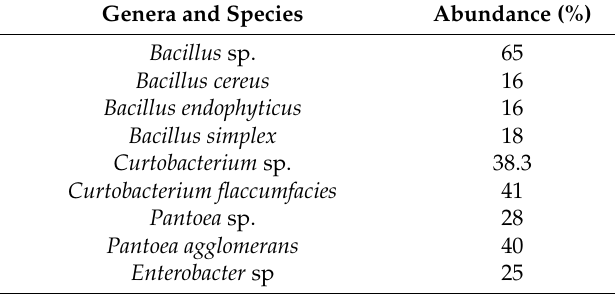
Table 5. Most abundant genera and species isolated among the bird samples